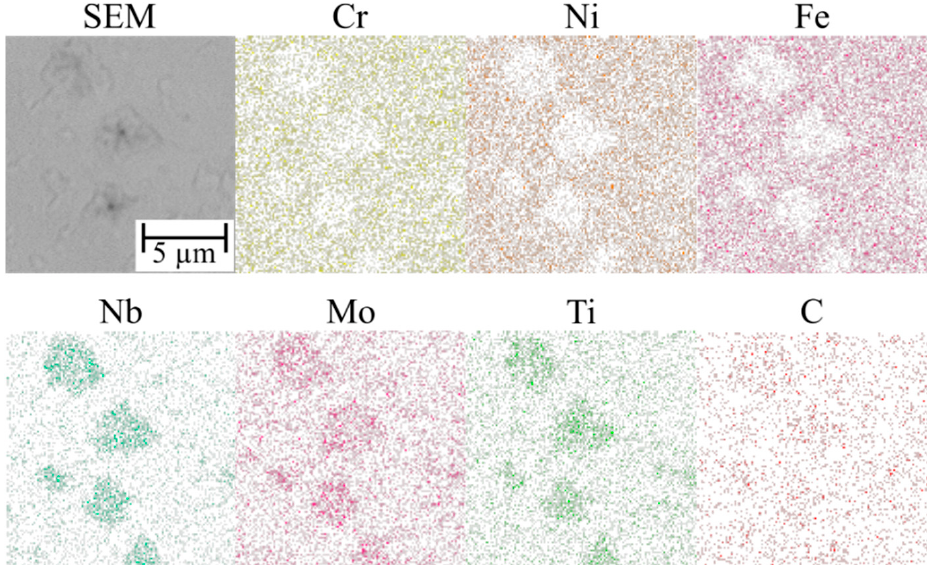
Figure 7. EDS maps of the composite Inconel 625/TiC coating matrix.